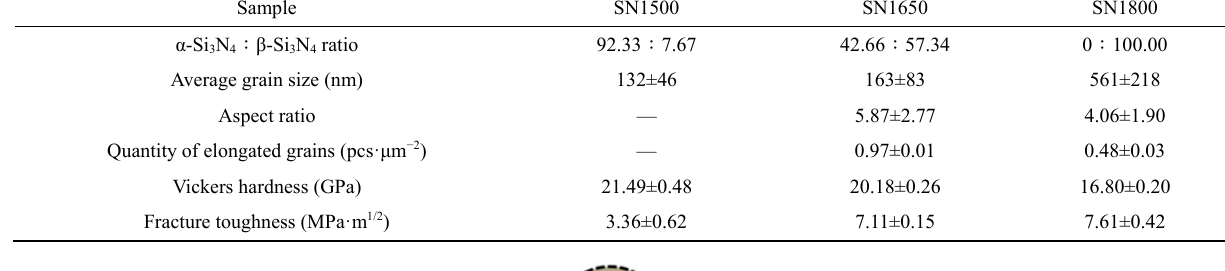
Table 2 Comparison of the phase fraction and microstructure features among the three samples in this work Sample SN1500